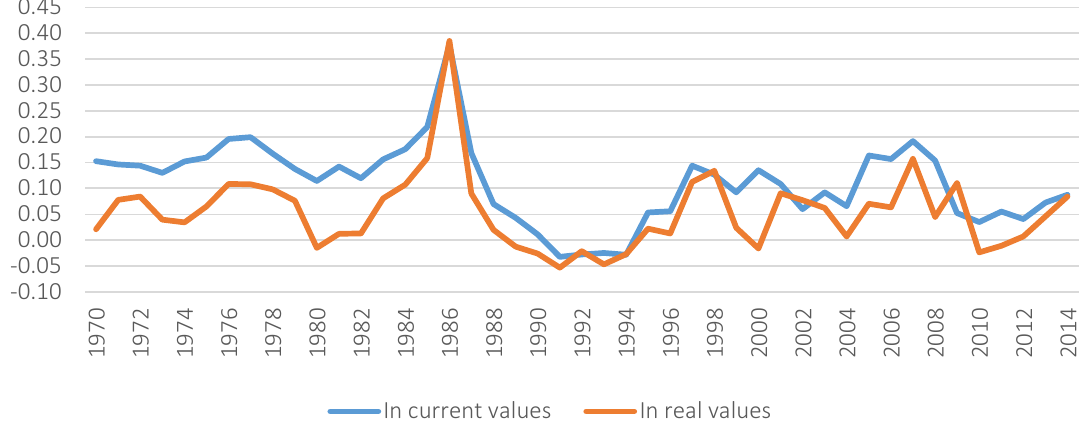
1970197219741976 1978 1980198219841986198819901992 1994 1996199820002002200420062008 2010 20122014 In current values In real Figure 6. Annual relative changes in total credits for Norway 1970–2014 in current and real prices (2015 = 100)